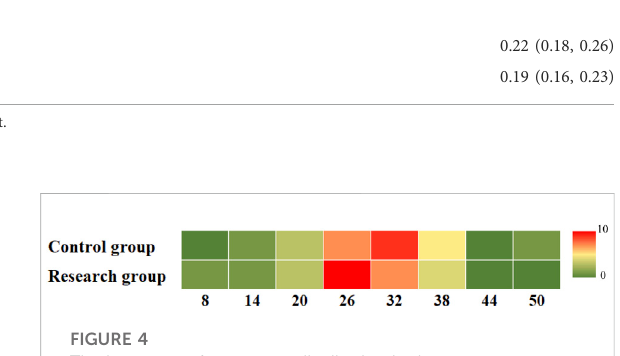
FIGURE 4 The heat map of vagueness distribution in the two